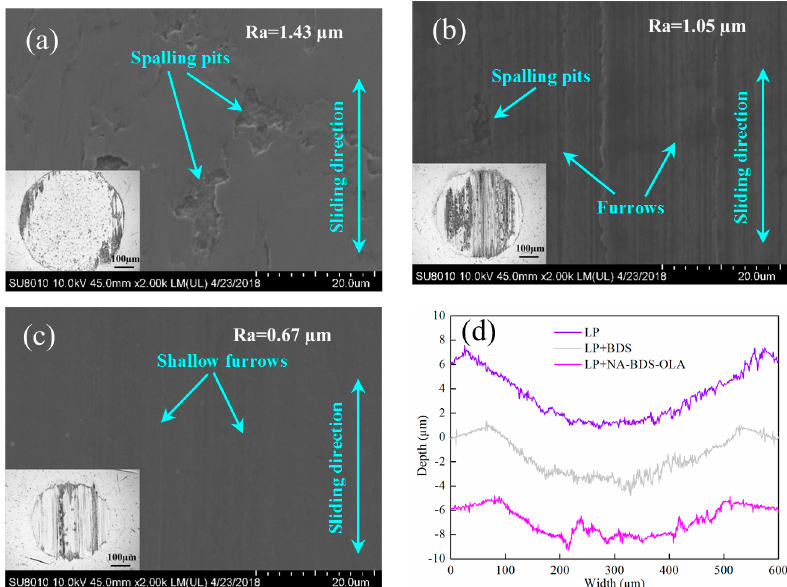
Figure 11. FESEM images and optical micrographs of wear scars on upper balls lubricated with ( a ) LP, ( b ) LP + BDS, and ( c ) LP + NA-BDS-OLA. ( d ) Corresponding worn surface profiles (soot content = 0.3 wt %, load = 100 N, speed = 50 mm/s, duration = 30 min).